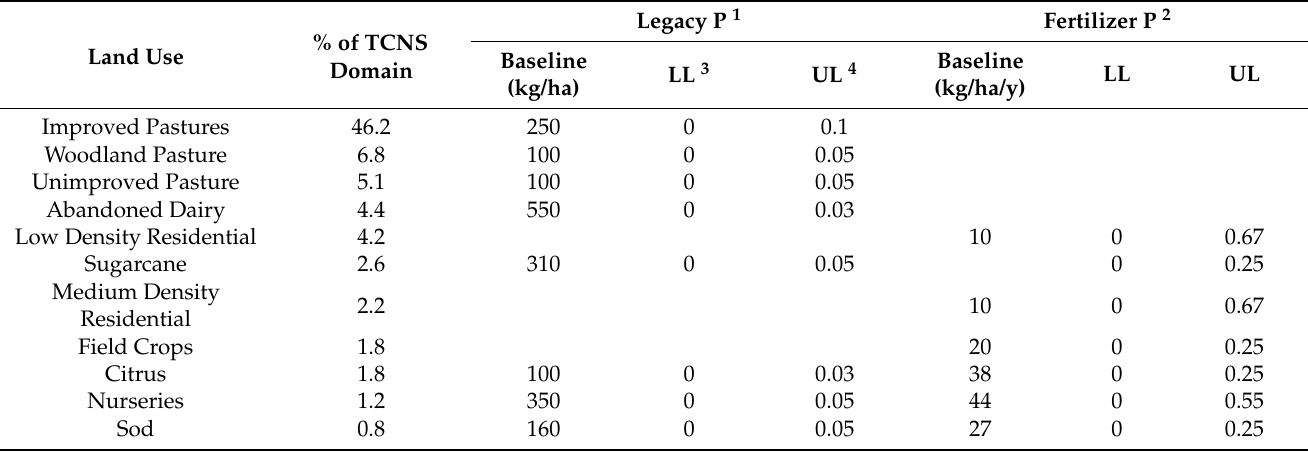
Table 1. Summary of the TCNS Land uses and EAAMOD Parameterization used in the Morris method.